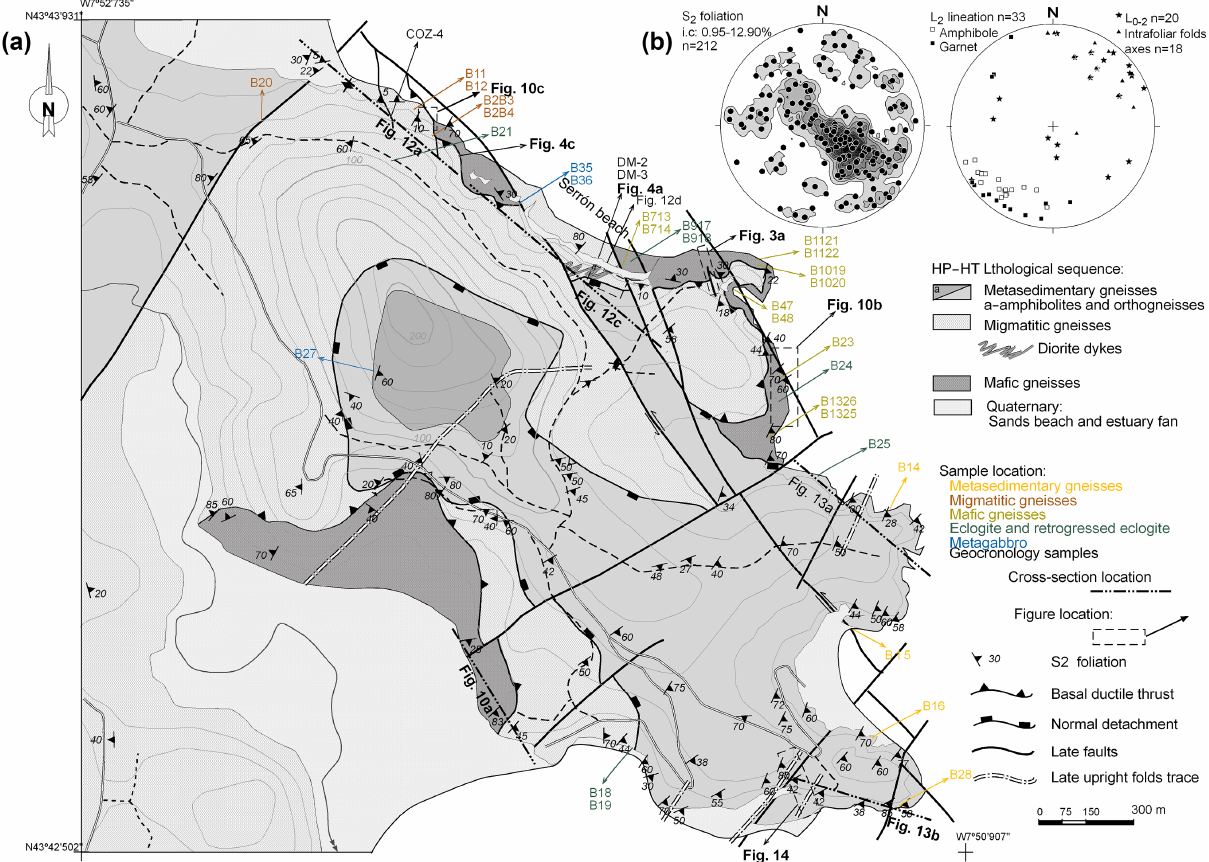
Figure 2. (a) Geological map of the Masanteo peninsula with location of samples, figures and cross-sections. Pole figures in (b) show the distribution of S 2 -foliation poles and related structures (lineation and intrafolial fold axes). Equal area projection, lower